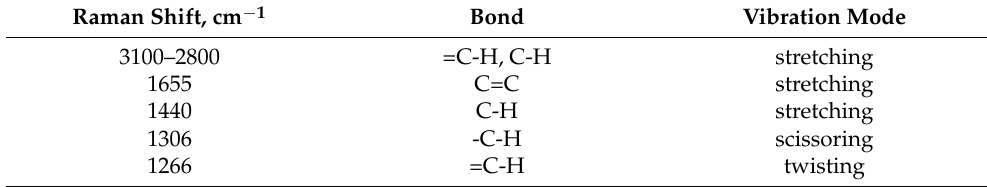
Table 1. The chemical shifts and vibration modes present in the Raman spectra of vegetable oil.